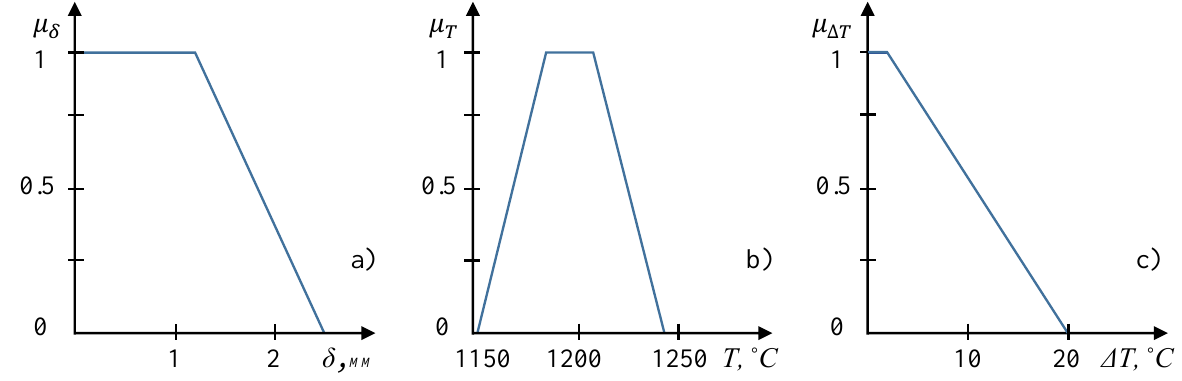
Figure 2. Membership functions ( a – c ) of the local criteria